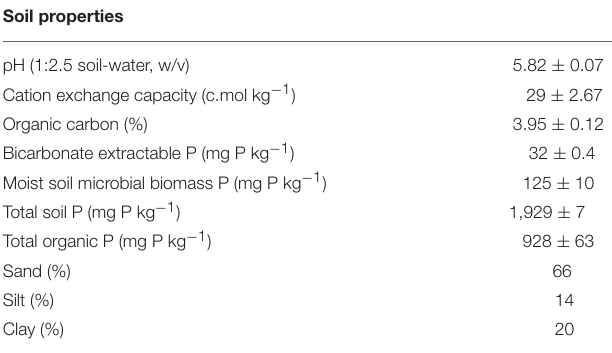
TABLE 2 | Initial soil properties (mean ± standard deviation n = 3) of Hallsworth